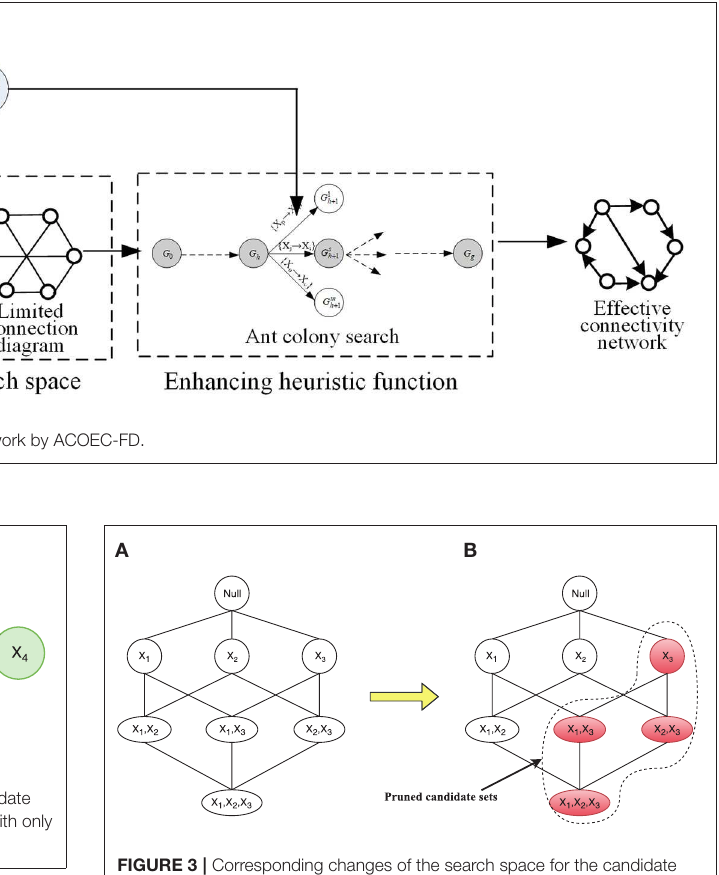
FIGURE 3 | Corresponding changes of the search space for the candidate parent node set for X 4 . (A) Search space equal to the whole state space. (B) Search space is reduced to four candidate parent node